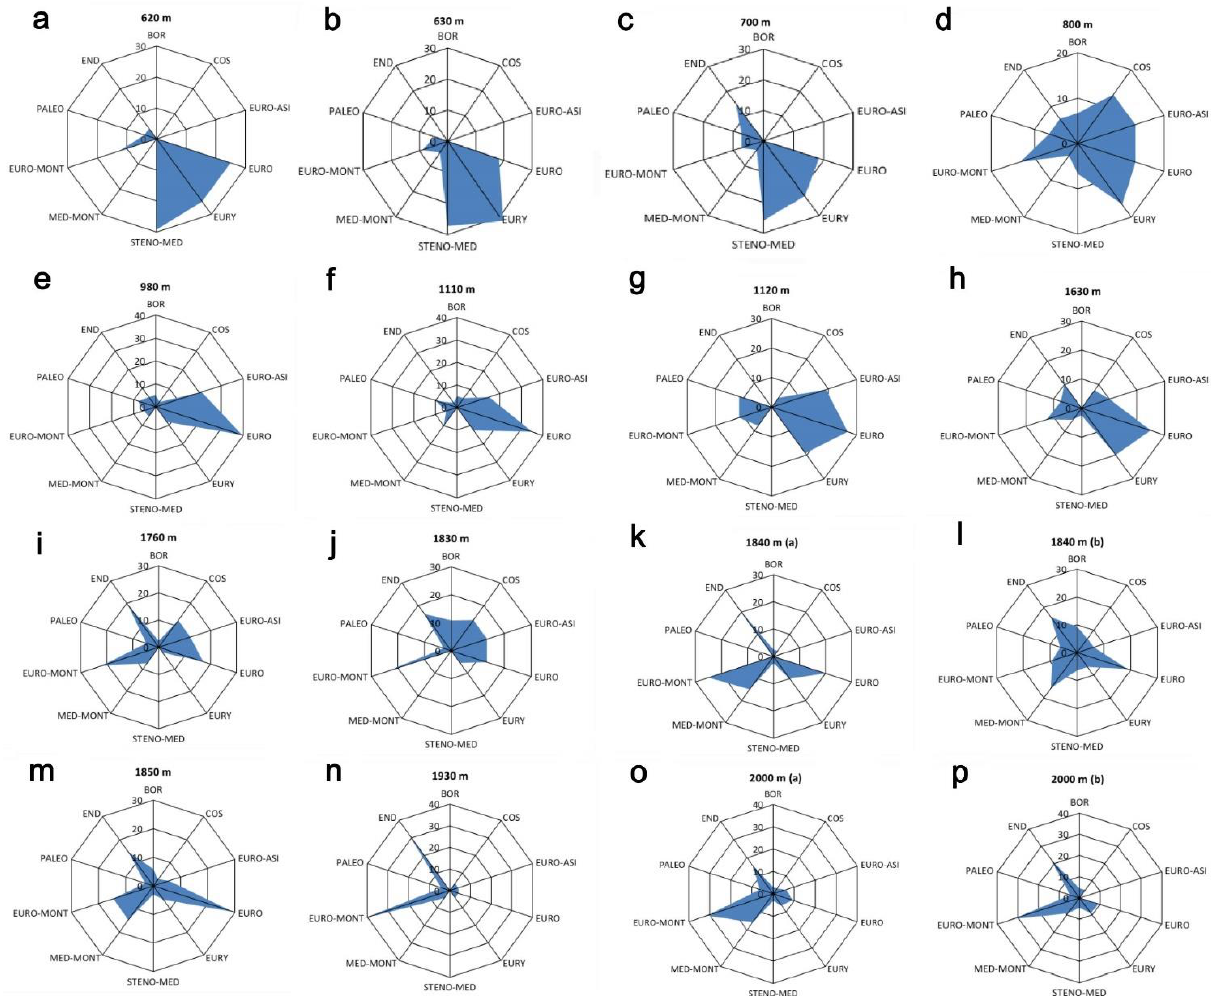
Figure 2. Percentage of different chorotypes found in plant assemblages along an elevational gradient on a Central Apennine mountain (Mount Genzana): ( a ) 620 m, ( b ) 630 m, ( c ) 700 m, ( d ) 800 m, ( e ) 980 m, ( f ) 1110 m, ( g ) 1120 m, ( h ) 1630 m, ( i ) 1760 m, ( j ) 1830 m, ( k ) 1840 m, ( l ) 1840 m, ( m ) 1850 m, ( n ) 1930 m, ( o ) 2000 m, ( p ) 2000 m. Chorotypes: BOR = Boreal, COS = Cosmopolitan, EURO-ASI = Euro-Asiatic; EURO = European; EURY = Eurymediterranean; STENO-MED = Stenomediterranean; MED-MONT = Mediterraneo-Montane; EURO-MONT = Euromontane; PALEO = Paleotemperate; END = Endemic. For 1840 m and 2000 m elevations, two relevés (conventionally indicated, in both cases, as a and b ) were available.